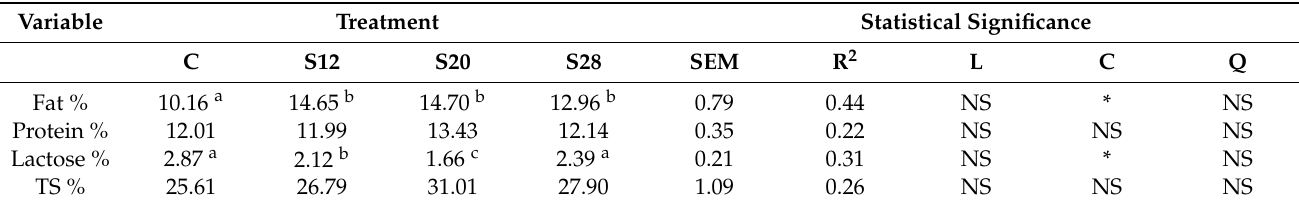
Table 3. The effect of different levels of sunflower hulls on the colostrum composition, as assessed 3 h postpartum. Variable